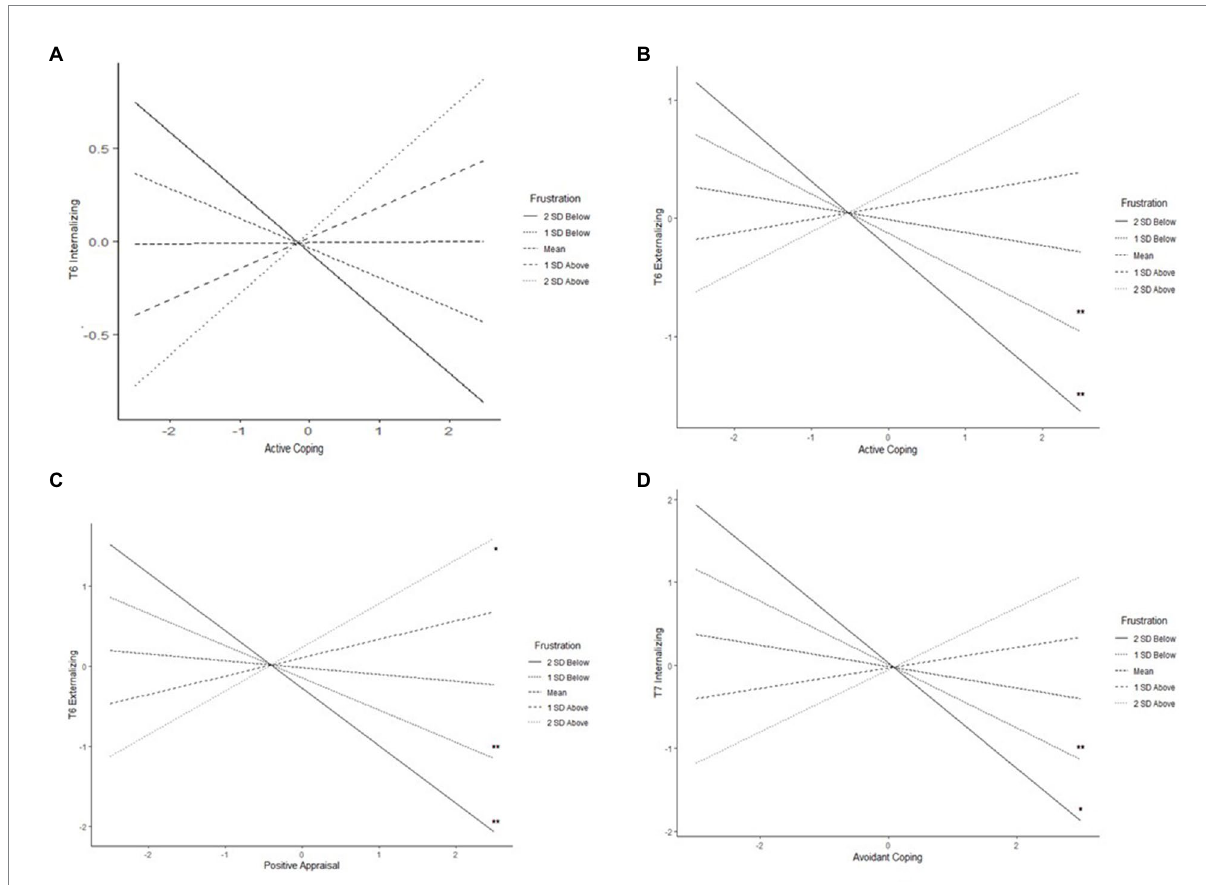
FIGURE 2 Frustration moderating the associations of (A) active coping with T6 internalizing, (B) active coping with T6 externalizing, (C) positive appraisal with T6 externalizing, and (D) avoidant coping with T7 internalizing (* p < 0.05, ** p < 0.01).